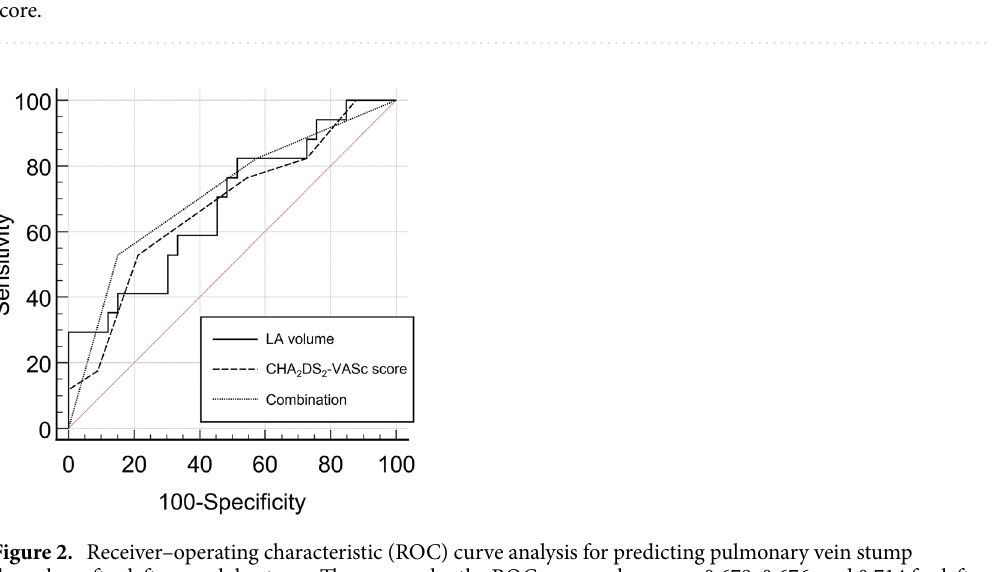
Figure 1. Scatterplot of left atrial volume versus CHA 2 DS 2 -VASc score. Patients who developed pulmonary vein stump thrombus tended to be clustered in the area of large left atrial volume and high CHA 2 DS 2 -VASc score.